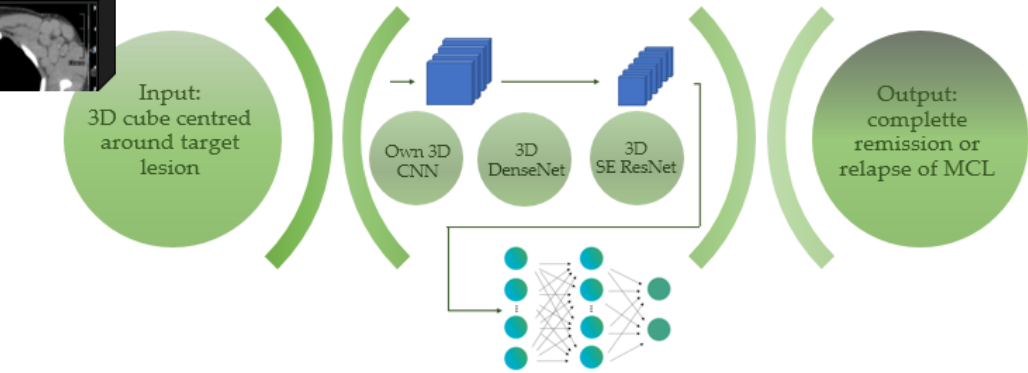
Figure 4. The schematic diagram for data processing in deep neural networks.